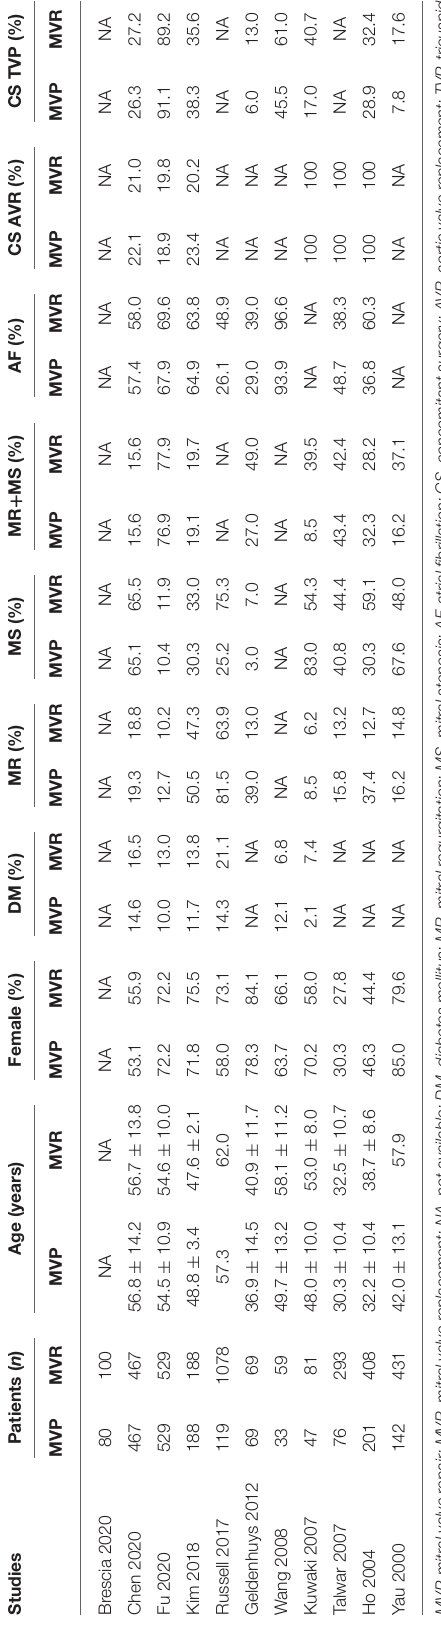
( Figure 3B ). Reconstructed Kaplan-Meier curves derived